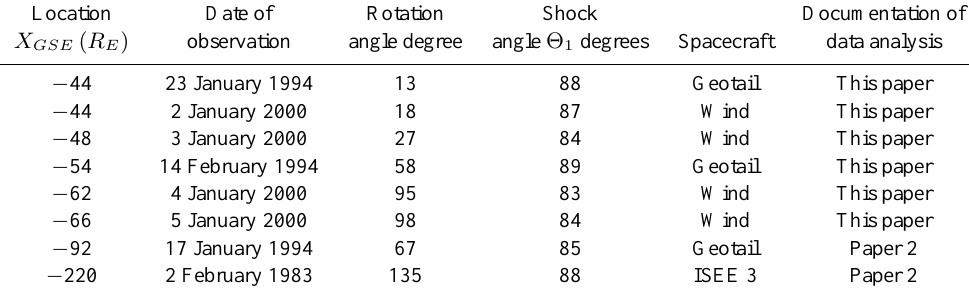
Table 1. A summary of double discontinuities in the magnetotail that have been documented in journal